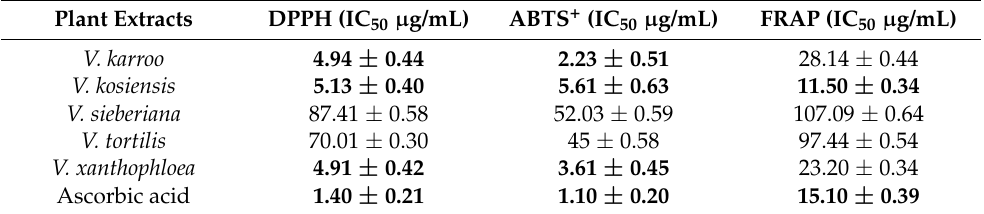
Table 2. Inhibitory concentration (IC 50 ) values of antioxidant activity of five Vachellia species and ascorbic acid (positive control). The IC 50 ( µ g/mL) values are expressed as the mean ± standard error ( n = 3). Bold values are considered noteworthy.